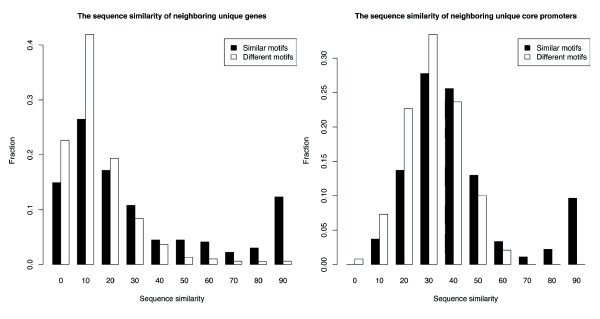
Sequence similarity of neighboring genes and their promoters. (A) The gene sequence similarity of neighboring unique gene pairs whose motifs are similar (black bars) or different (white bars). (B) The promoter sequence (-130 to +50 bp) similarity of neighboring unique gene pairs whose motifs are similar (black bars) or different (white bars).